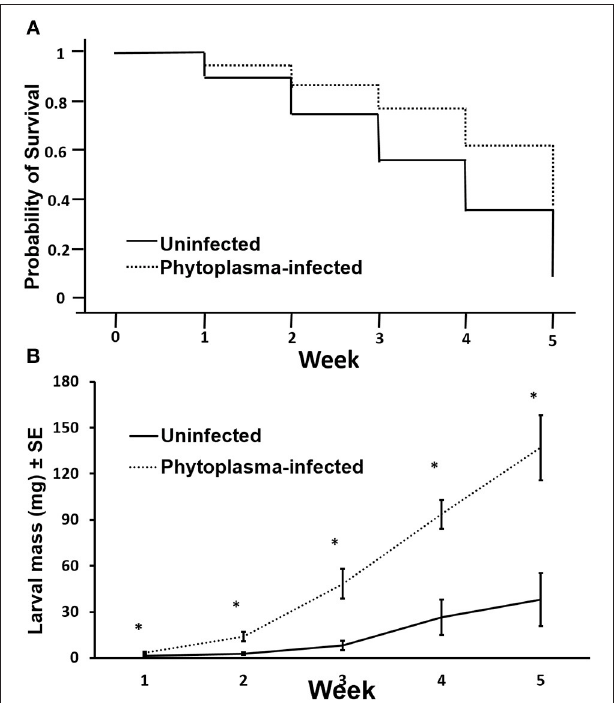
FIGURE 3 | Survival (Kaplan-Meyer curve) (A) and mass (B) of gypsy moth ( Lymantria dispar ) larvae fed on uninfected and phytoplasma-infected cranberry leaves for 5 weeks. Asterisks indicate statistically significant differences (* p ≤ 0.05). N = 15.